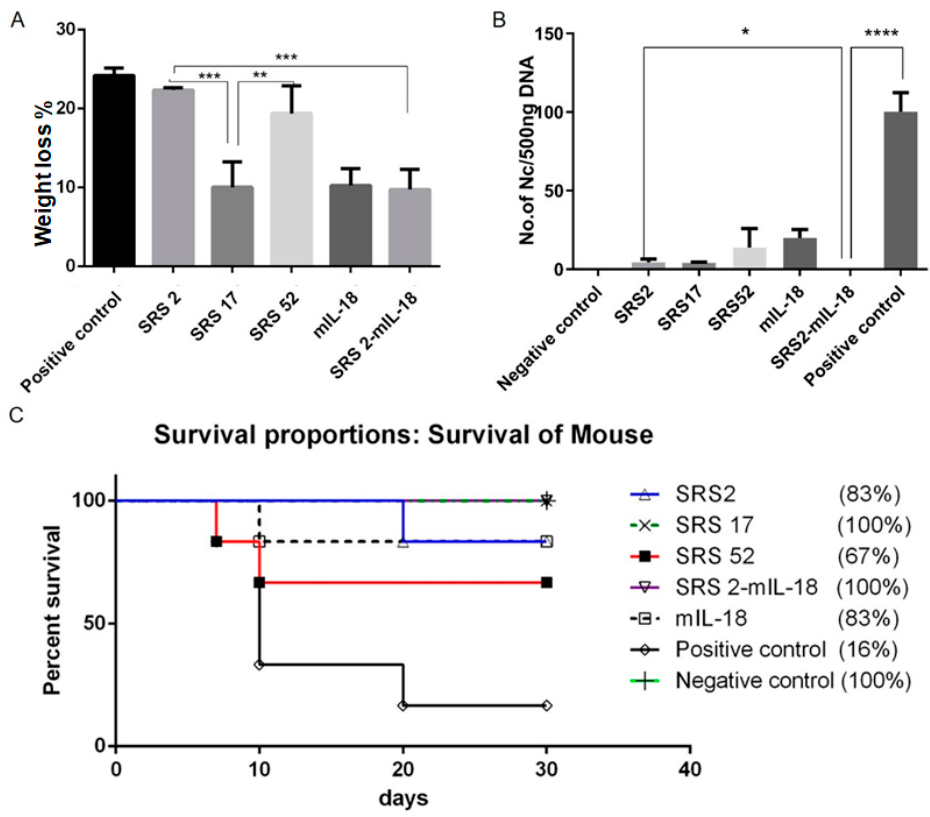
Figure 3. Immunoprotective effects of recombinant NcSRS2, NcSRS17, NcSRS52 and mIL18 proteins on mice after N. caninum infection. ( A ) Mouse weight loss results. The mice in each group were weighed before N. caninum infection and 10 days after N. caninum infection; all weights were recorded. The average weights of all the groups at the time of N. caninum infection were compared. ( B ) The amount of N. caninum in mouse brain tissue was shown by quantitative real-time PCR. ( C ) Survival curves of BALB/c mice vaccinated against N. caninum infection. “ * ” represents p < 0.05, “ ** ” represents p < 0.01, “ *** ” represents p < 0.001, “ **** ” represents p < 0.0001.